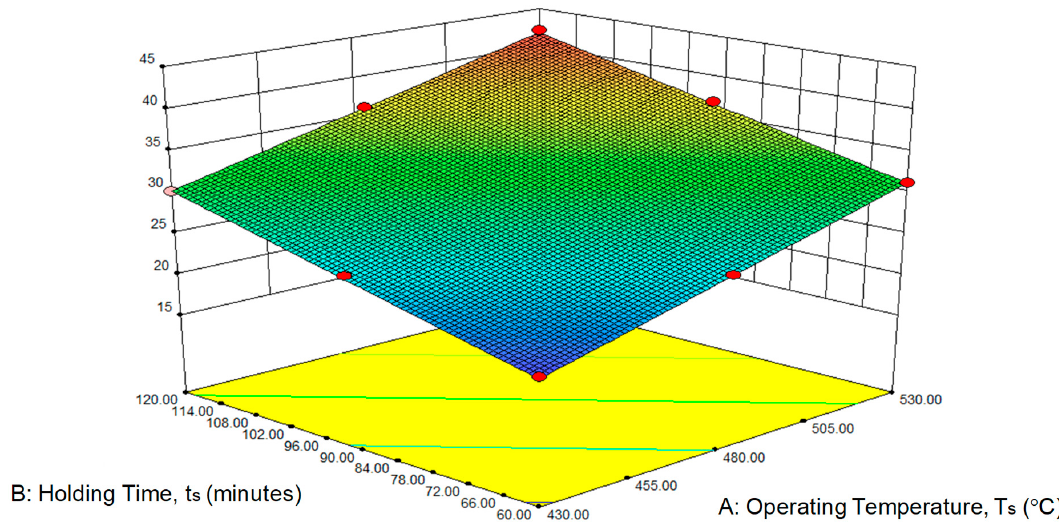
Figure 8. Effect of the ( A ) operating temperature and ( B ) holding time on global warming potential, GWP.